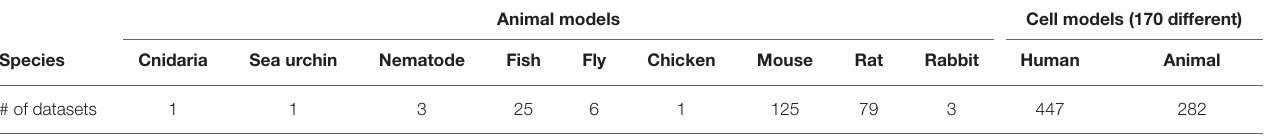
TABLE 2 | Biological models (animals or cell and tissue cultures) used in the 316 selected studies.